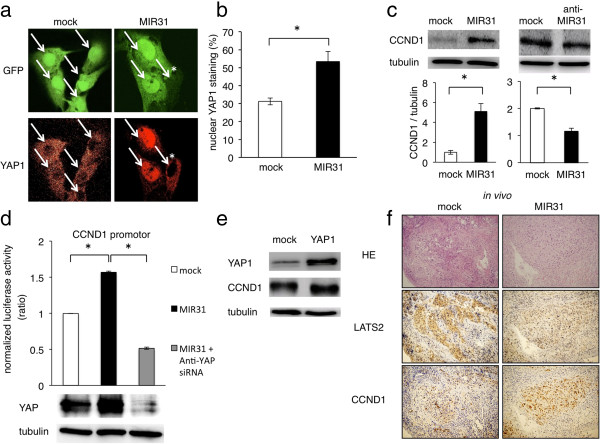
MIR31 promotes the translocation of YAP1 into the nucleus and promotes the transcription of CCND1. (a) Representative cells of immunofluorescence for GFP and YAP1, x600. The nuclei are indicated by white arrows. *The translocation of YAP1 into the nucleus was not observed in the cells unsuccessfully transfected with pre-MIR31. The cells were cultured under standard conditions with 5% fetal bovine serum. (b) Ratio of nuclear YAP1 staining. *p < 0.05, unpaired two-tailed Student’s t-test. (c) The CCND1 levels were increased by MIR31 overexpression and the CCND1 levels were decreased by the MIR31-specific inhibitor on immunoblotting for CCND1 and α-tubulin. The ratio of CCND1/α-tubulin is shown in the bar graph. (d) The CCND1 levels were increased by YAP1 overexpression. Immunoblotting for YAP1, CCND1 and α-tubulin. (e) The luciferase activity after transfection of the reporter constructs containing the LATS2 promotor region normalized to the GAPDH promotor region (top). Immunoblotting for YAP and α-tubulin following siRNA transfection (bottom). Mock and MIR31 cells were transfected with non-targeting siRNA. *p < 0.05, unpaired two-tailed Student’s t-test. (f) Correlation between the MIR31 expression and results of the immunohistochemical analysis of LATS2 and CCND1 in vivo. Representative results are shown in micrographs, x100. All experiments were performed in triplicate.